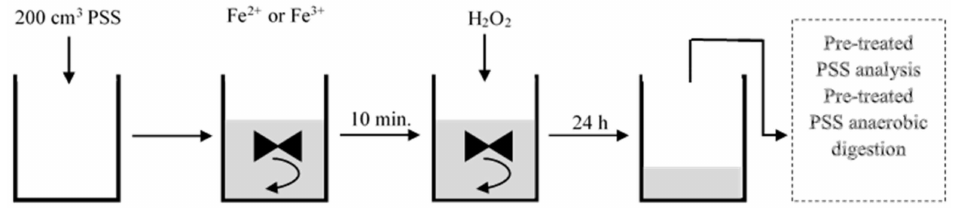
Figure 2. Scheme of the experiment organization in Phase 1—AOP